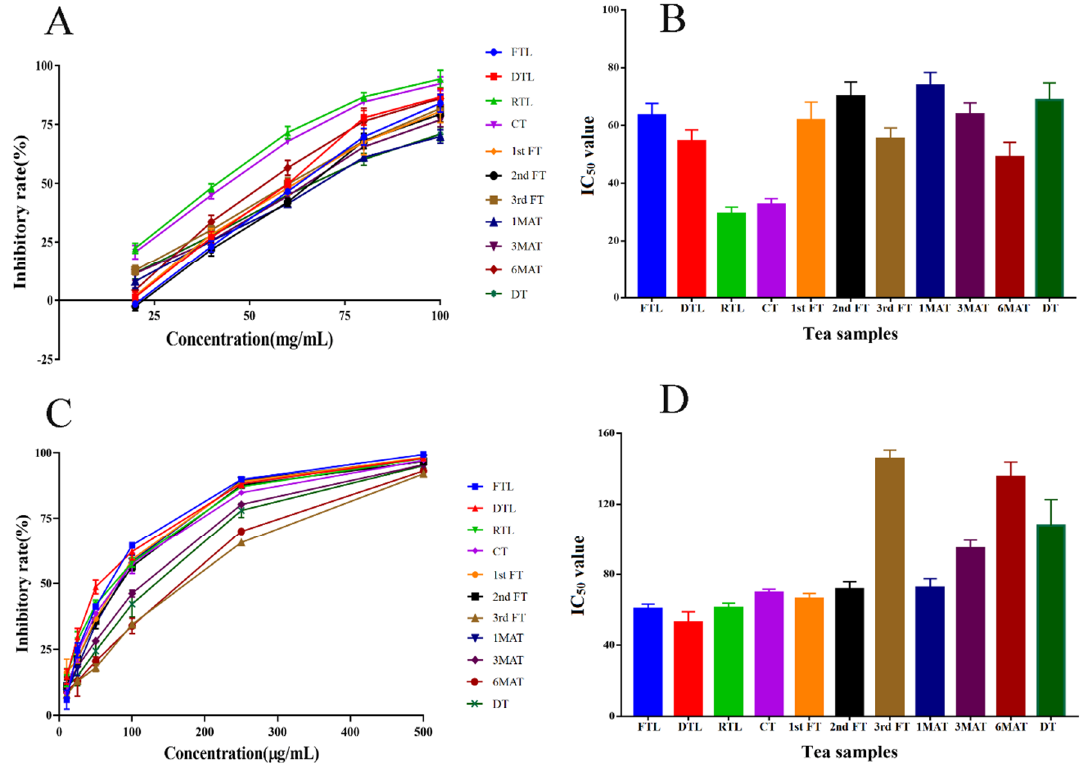
Figure 4. The inhibitory effects of different QZT samples on α-amylase and α-glucosidase. ( A ) Inhibitory rates of different QZT samples with various concentrations on α-amylase. ( B ) IC 50 values of different QZT samples on α-amylase: FTL: 63.48 mg/mL; DTL: 54.59 mg/mL; RTL: 29.47 mg/mL; CT: 32.59 mg/mL; 1st FT: 61.93 mg/mL; 2nd FT: 70.16 mg/mL; 3rd FT: 55.42 mg/mL; 1MAT: 73.86 mg/mL; 3MAT: 63.98 mg/mL; 6MAT: 49.07 mg/mL; DT: 68.88 mg/mL. ( C ) Inhibitory rates of different QZT samples with various concentrations on α-glucosidase. ( D ) IC 50 values of different QZT samples on α-glucosidase: FTL: 60.54 µg/mL; DTL: 52.91 µg/mL; RTL: 61.01 µg/mL; CT: 69.57 µg/mL; 1st FT: 66.26 µg/mL; 2nd FT: 71.60 µg/mL; 3rd FT: 145.60 µg/mL; 1MAT: 72.54 µg/mL; 3MAT: 94.72 µg/mL; 6MAT: 135.57 µg/mL; DT: 107.94 µg/mL.